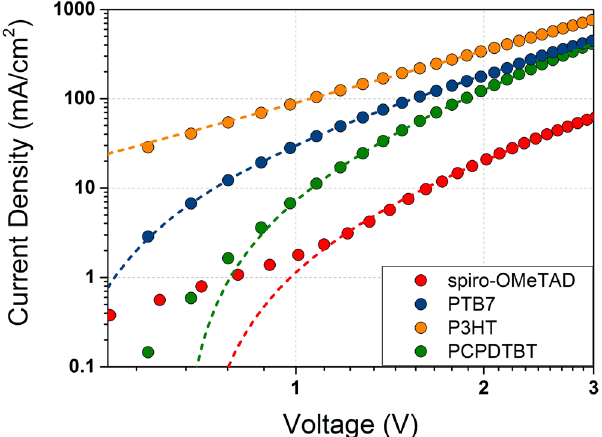
Figure 10. Current density vs. voltage measurements of the devices ITO/PEDOT:PSS/HTM/Au for each HTM used in this study. The dashed lines correspond to the fitting of the experimental data to Eq.